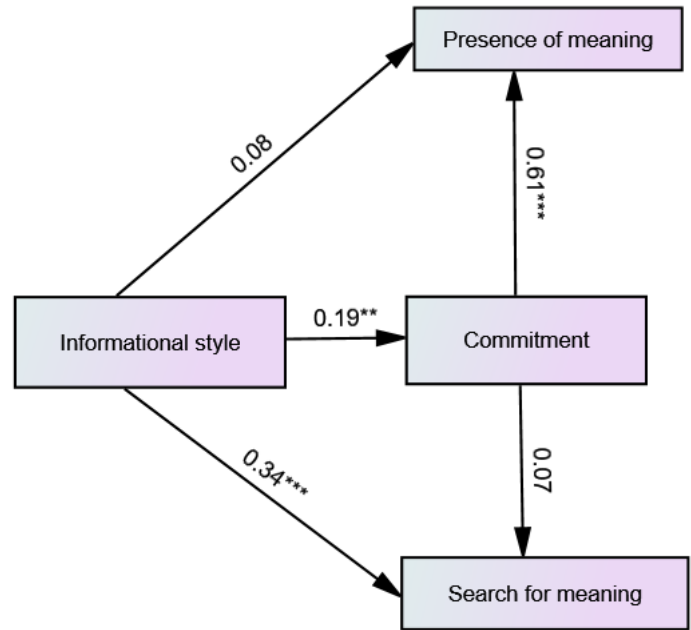
Figure 4. Path diagram of the predictive relationships between informational identity style, com- mitment, presence of meaning and search for meaning, including the standardized path coefficients. ** p < 0.01. *** p < 0.001.